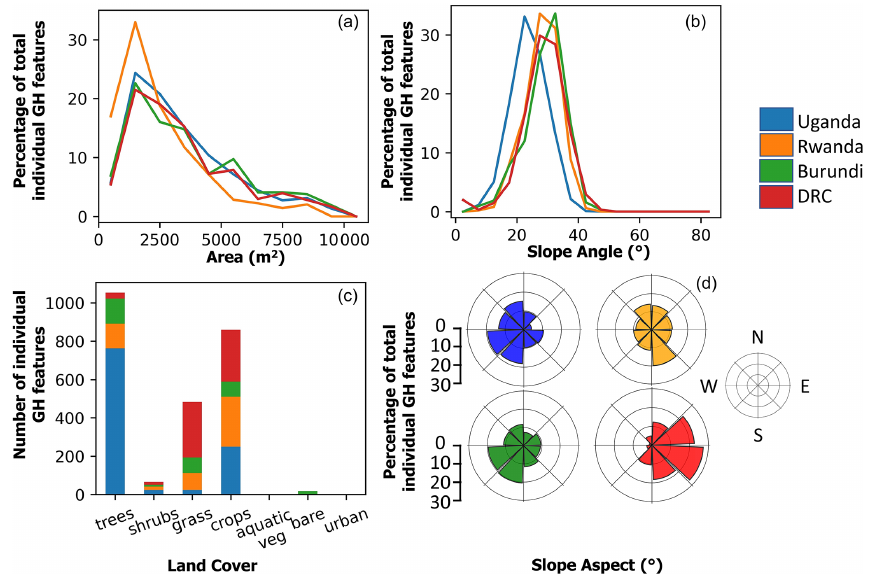
Figure 5. Parameter distributions per GH event (Uganda, Rwanda, Burundi, and DRC). (a) Percentage of individual GH over total amount of individual GH against area (m 2 ), bins of 1000m 2 . (b) Percentage of individual GH over total amount of individual GH against slope angle, bins of 5 ◦ . (c) Amount of individual GH against land use/land cover. (d) Percentage of individual GH over total amount of individual GH against slope aspect, bins of 15 ◦